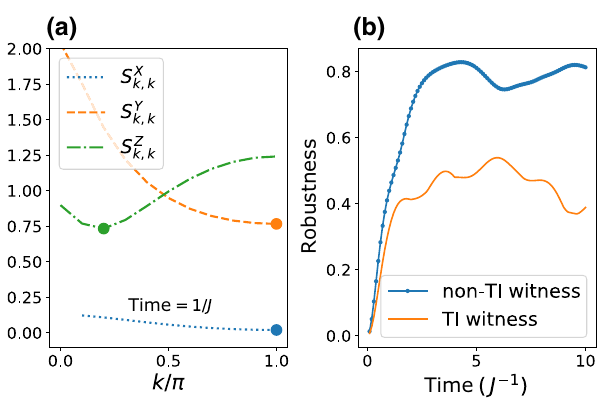
FIG. 3. Quench in the two-dimensional XX model on a 20 × 20 square lattice with open boundary conditions [Eq.(14)]. (a) Structure factor at time t = 1 / J . The circles mark the wave vec- tors at which the structure factor for the X , Y , and Z components is minimal. This leads to the TI witness of Eq. (17). (b) Blue dots: noise robustness of the optimal witness found by our SDP and two-body cor- algorithm using as input the magnetization C X i , C YY , and C ZZ , with an initial state polarized along relations C XX ij ij ij x . Orange line: noise robustness of the best TI witness of Eq. (17), whose reconstruction is illustrated on (a) for time t = 1 / J